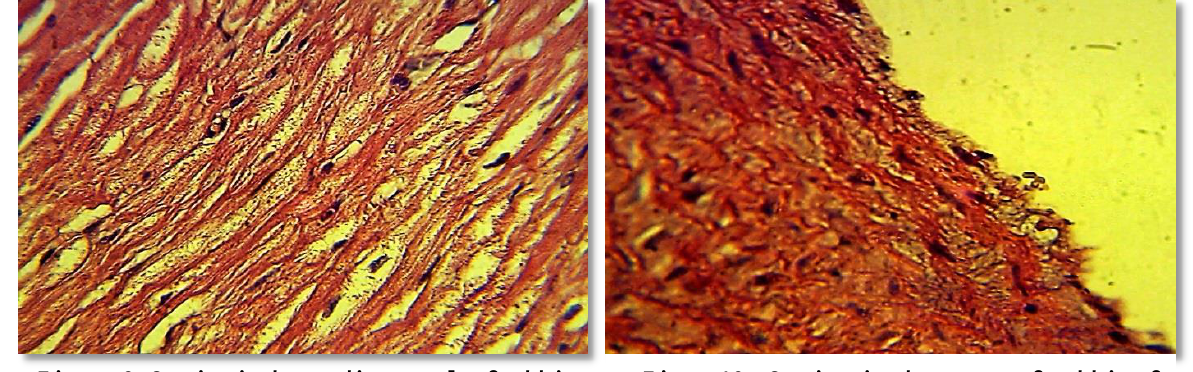
Figure, 9: Section in the cardiac muscle of rabbit treated with pometon (PSO) only for 42 day (group T3) . Note: no clear lesions (H &E stain 40X).